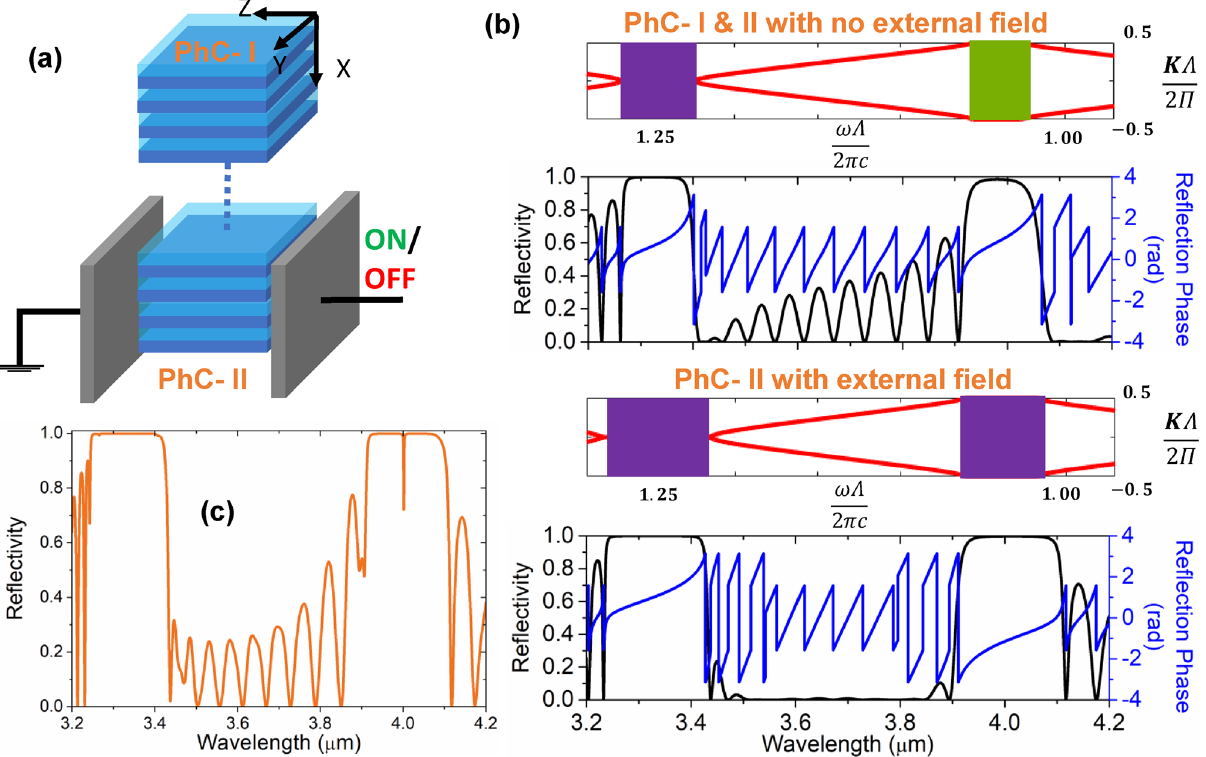
Figure 3. ( a ) Schematic for the TIS modulator; ( b ) electro-optically induced phase transition: bandstructure and scattering characteristics of the constitutive PhCs with and without external electric field; ( c ) manifestation of an extinguishable TIS in the integrated